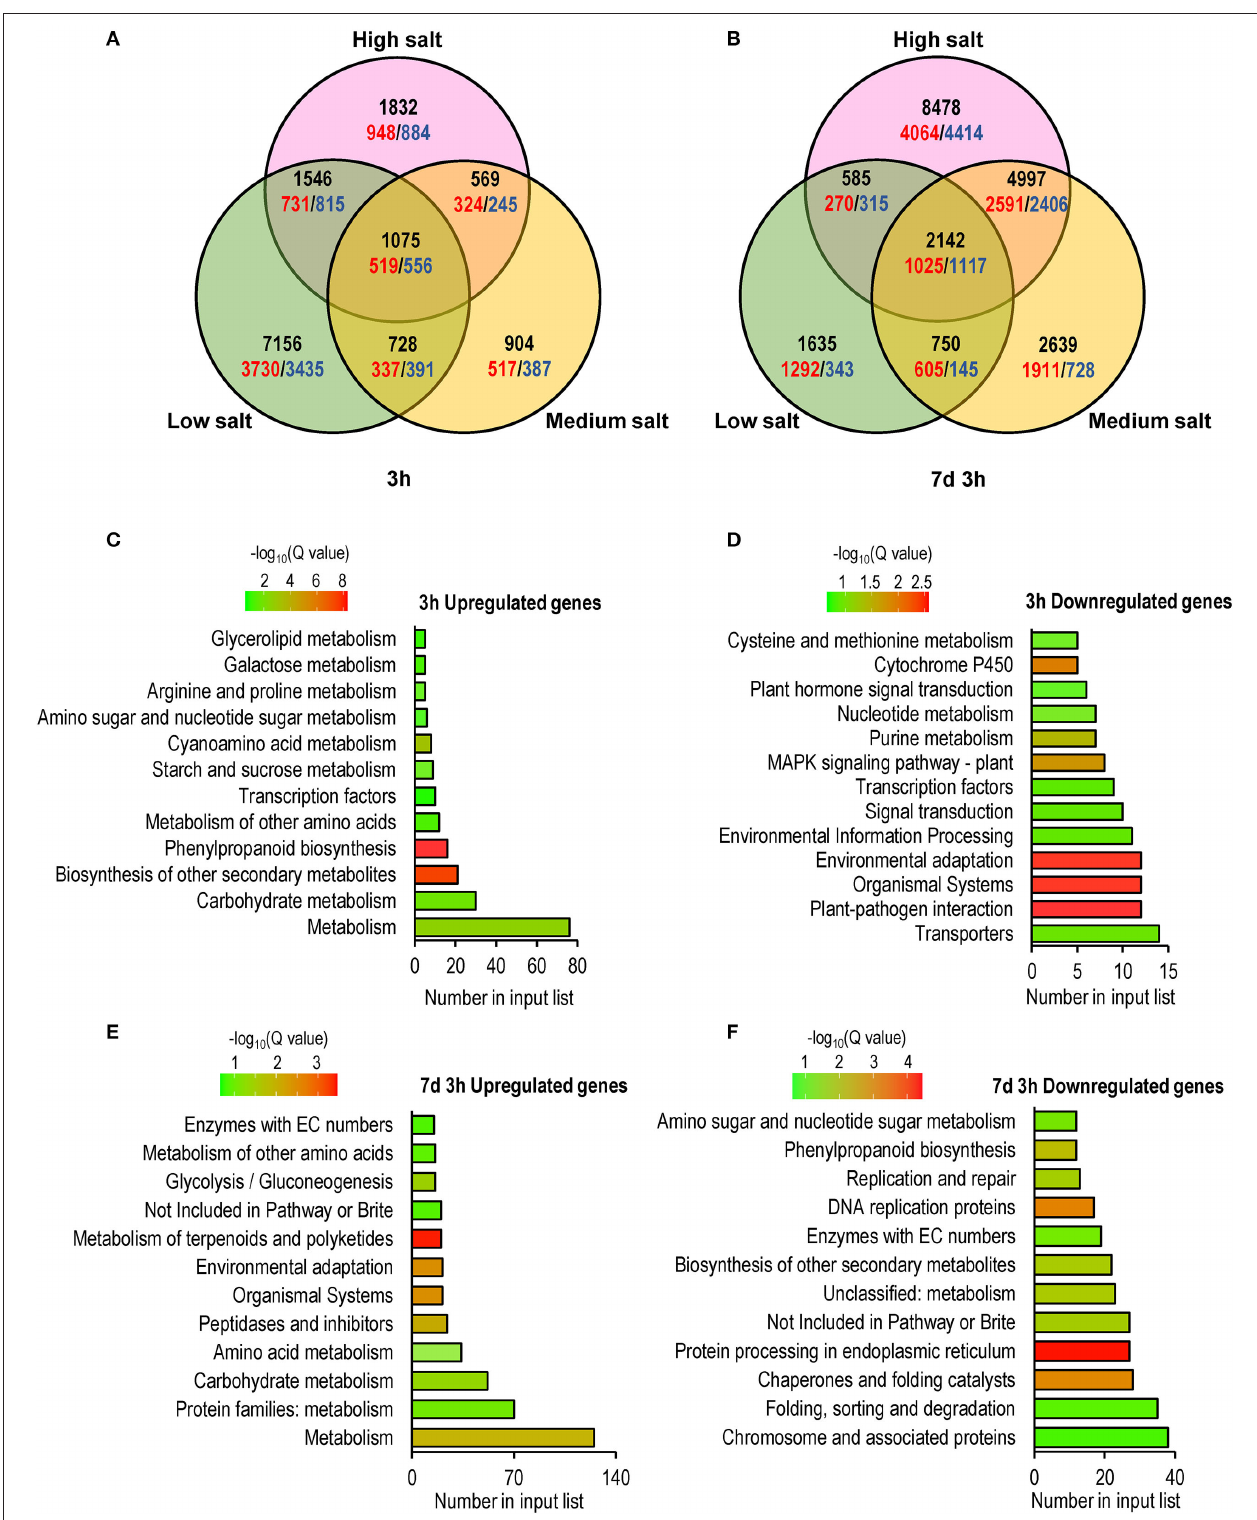
FIGURE 5 | Global comparison of transcriptome profiling identified early and long-term salt response genes. (A) Venn diagrams indicating the numbers of early (3h) and long-term (7 days and 3h) salt-related genes compared to no salt control. The unregulated genes were colored red while downregulated genes were colored blue, and the total numbers were black. KEGG enrichment analysis of salt-response genes commonly regulated after 3h (C,D) or 7 days and 3h (E,F) treated in salt of all levels.